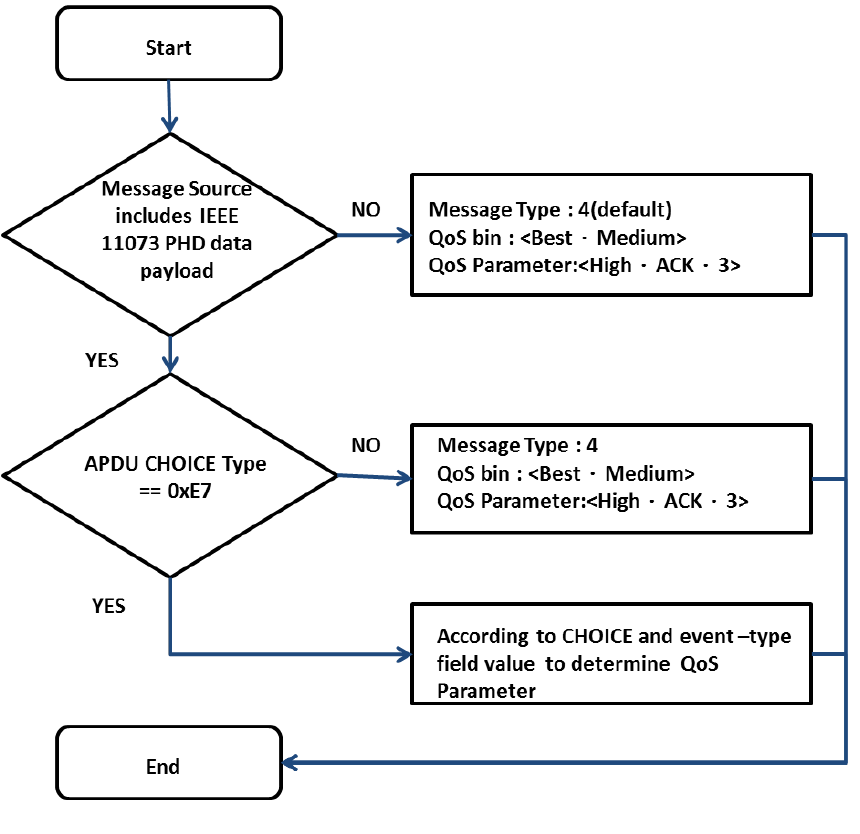
Figure 5. Message Type & QoS Control Parameters Decision Flow.